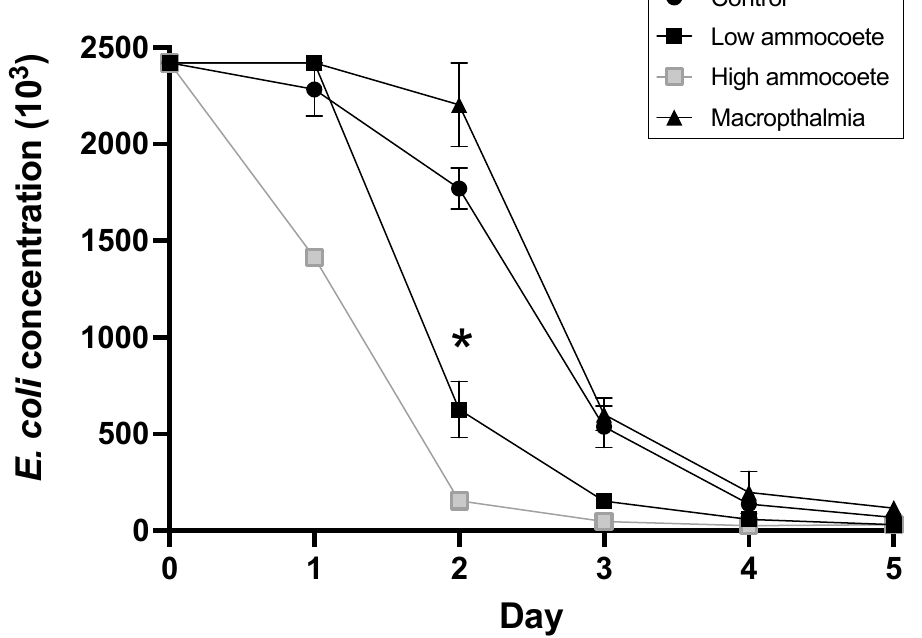
Figure 2. Changes in E. coli concentration values (mean ± standard error) over the 5 d study period. On day 2, the ‘Ammocoete’ treatment had a significantly lower viable E. coli concentration than either the ‘Macropthalmia’ or ‘Control’ treatments. The * indicates the day upon which significantly different estimates between ‘Control’ and ‘Ammocoete’ as well as between ‘Macropthalmia’ and ‘Ammocoete’ were observed. Note, the ‘Ammocoete’ treatment was not replicated and therefore not included in the statistical analyses. Note that standard error values for the ‘Ammocoete low’ treatment on day 3 lie within the point.